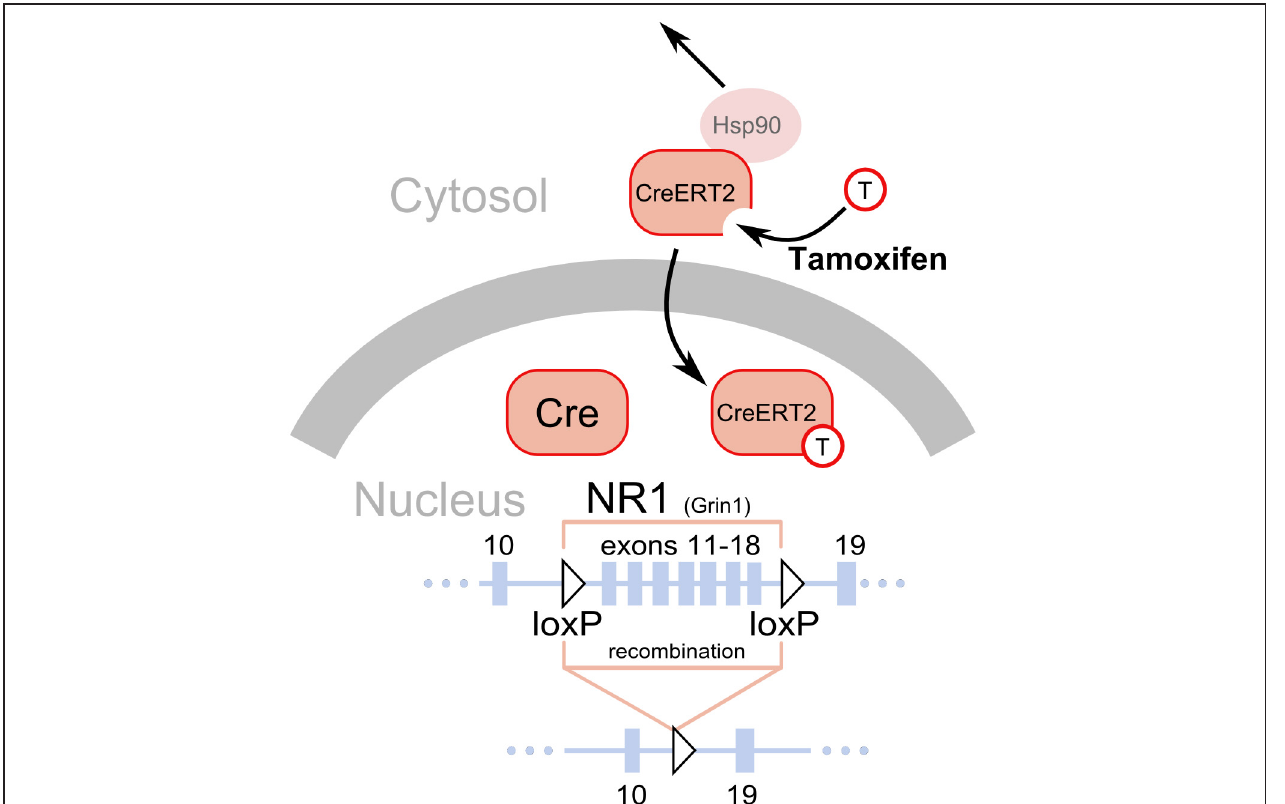
FIGURE 1 | Deletion of loxP flanked sequences by the Cre recombinase. A fragment of the NR1 ( Grin1 ) gene is shown as a line with solid black rectangles representing exons. The numbers above the rectangles correspond to exons. The two triangles represent the loxP sequences introduced in introns, placed in the same orientation and flanking exons 11–18 (Niewoehner et al., 2007). The Cre recombinase has a nuclear localization signal and is normally shuttled to the nucleus after translation, where it catalyzes a deletion of the gene fragment flanked by the loxP sites. Thus, gene inactivation will occur soon after the gene promoter driving Cre expression becomes active, typically around the 13th day of embryonic